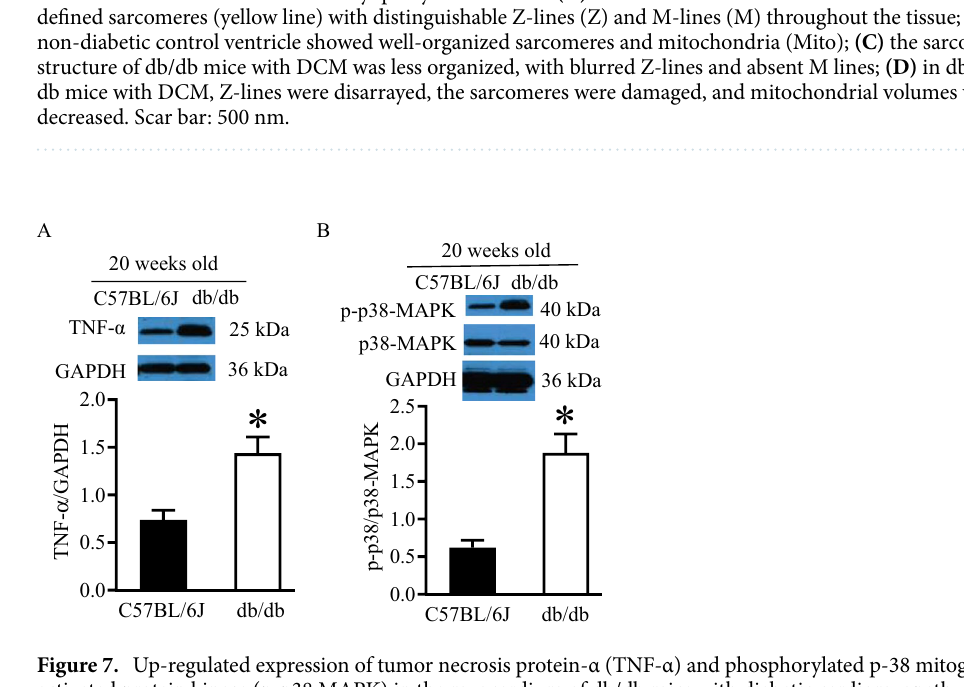
Figure 7. Up-regulated expression of tumor necrosis protein-α (TNF-α) and phosphorylated p-38 mitogen- activated protein kinase (p-p38 MAPK) in the myocardium of db/db mice with diabetic cardiomyopathy. (A) The expression of myocardial TNF-α. Top: representative Western blot bands of TNF-α and glyceraldehyde-3- phosphate dehydrogenase (GAPDH). Bottom: the ratio of TNF-α/GAPDH; (B) the expression of myocardial p-p38 MAPK and p38 MAPK. Top: representative western blot bands of p-p38 MAPK, p38 MAPK, and GAPDH as control. Bottom: the ratio of p-p38-MAPK/p38 MAPK. *P < 0.05 versus C57BL/6J groups (n = 5 mice/group). The Western blot bands were cropped from Figure S6, which were pointed by red arrows. In Figure S6, the original images of Western blot bands included C57BL/6J and db/db mice at 6 weeks of age in addition to 20-week-old mice, and several Western blot experiments were put on a big